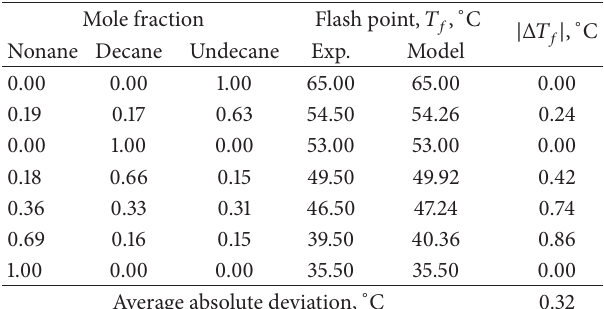
Table 9: Flash point of nonane + decane + undecane with different mole fractions